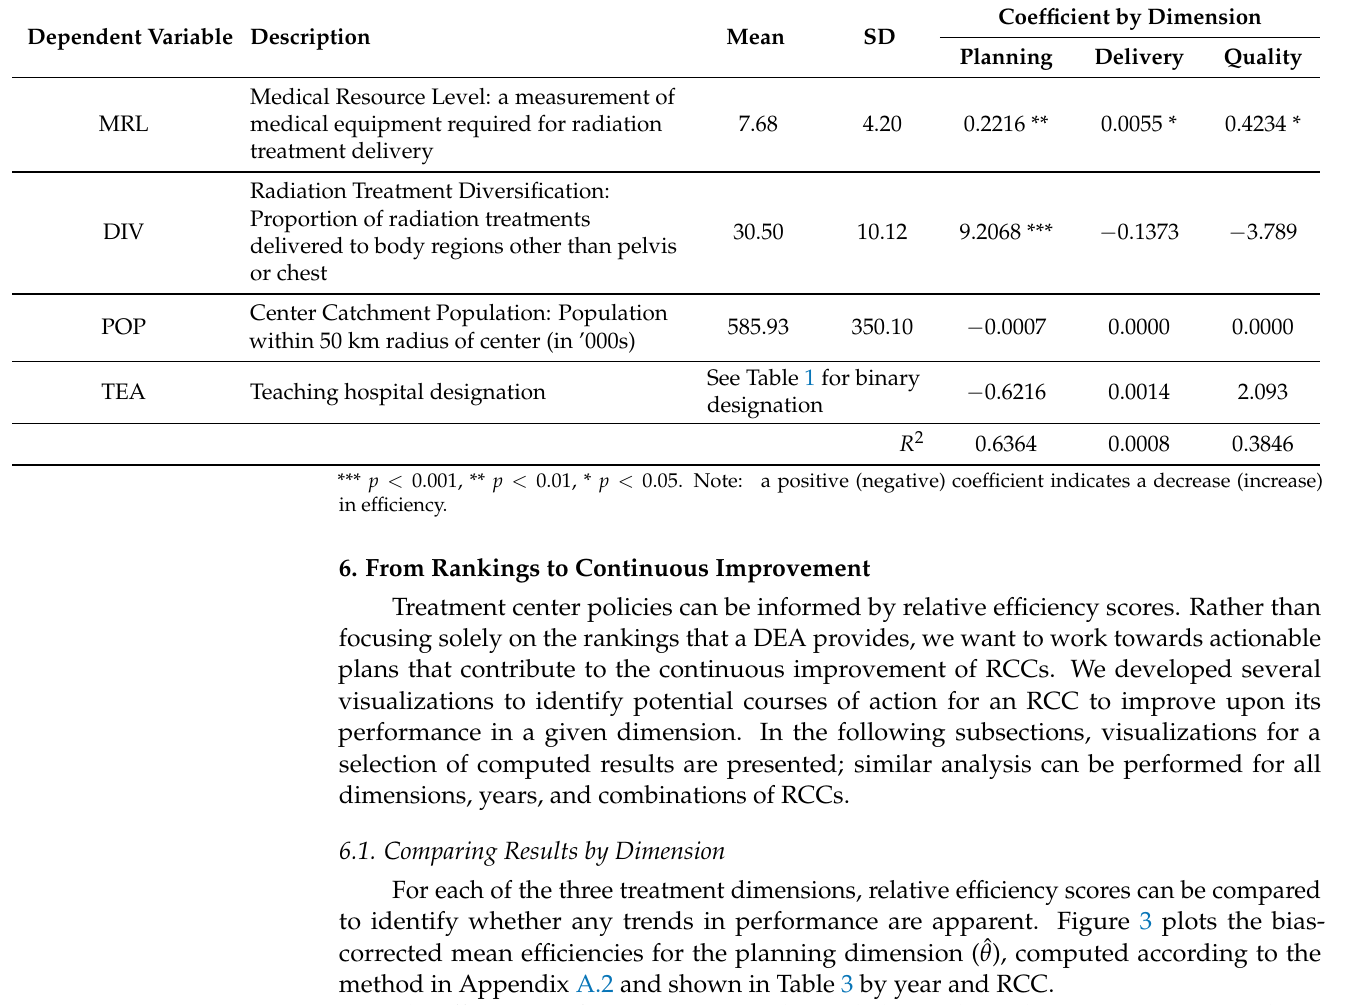
Table 6. Regression variables and